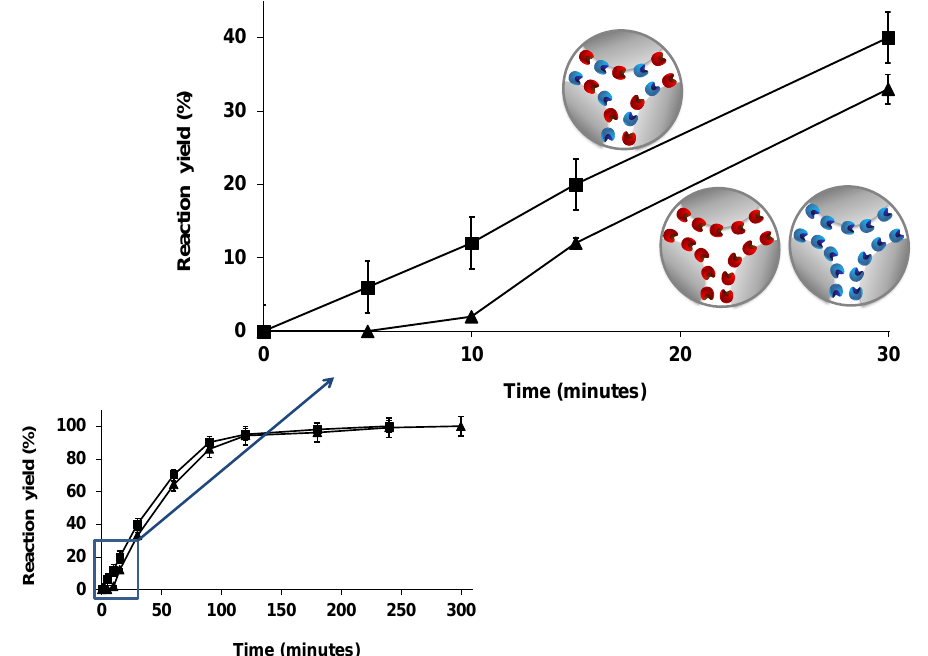
Figure 23. E ff ect of coimmobilization versus independently immobilized enzymes in a cascade reaction Figure 23. Effect of coimmobilization versus independently immobilized enzymes in a cascade course. The e ff ect is mainly relevant in the initial reactions rate because the lag time can disappear, but reaction course. The effect is mainly relevant in the initial reactions rate because the lag time can no so much in the whole reaction disappear, but no so much in the whole reaction course.